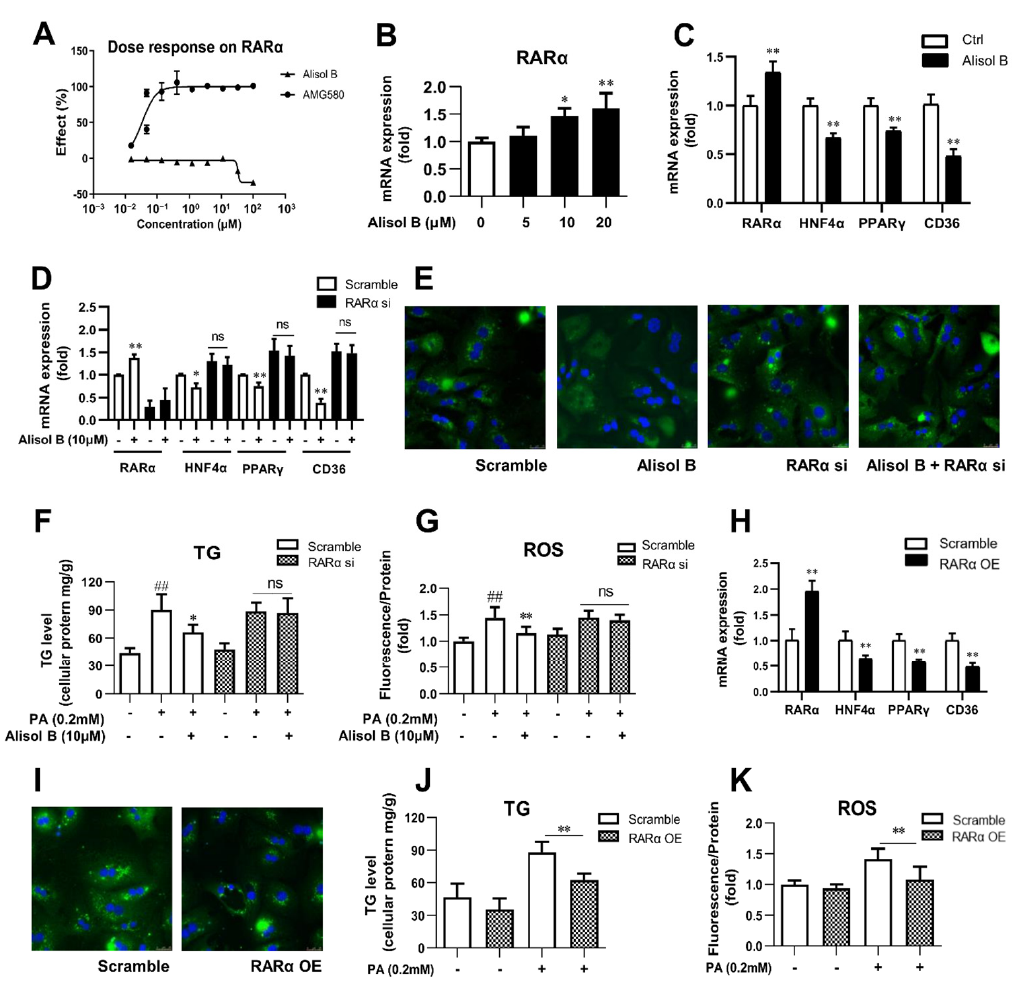
Figure 7. Alisol B decreased CD36 expression and attenuated hepatocyte lipid accumulation and lipotoxicity via regulating RAR α -HNF4 α -PPAR γ cascade. ( A ) HEK293 cells were transient transfected and then treated with Alisol B. The agonistic activity on RAR α was detected in luciferase reporter assay. ( B ) The gene expression of RAR α was detected. ( C ) The mRNA levels of RAR α , HNF4 α , PPAR γ , and CD36 were measured in hepatocytes treated with Alisol B (10 μ M). ( D – G ) Primary hepatocytes were transfected with RAR α siRNA for 24 h and then treated with Alisol B (10 μ M). ( D ) The mRNA levels of RAR α , HNF4 α , PPAR γ , and CD36; ( E ) BODIPY-C16 fluorescence (600× magnification); ( F ) cellular TG; and ( G ) cellular ROS were detected. ( H – K ) Primary hepato- cytes were overexpressed with RAR α via transient plasmid transfection for 24 h. ( H ) The mRNA cellular TG; and ( K ) cellular ROS were conducted. Data are expressed as mean ± SD, n = 5. In